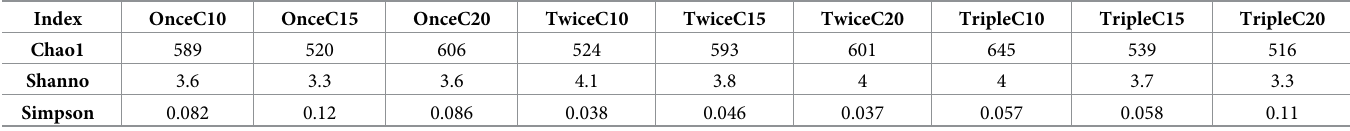
Table 4. Bacterial diversity in shrimp Litopeaneus vanname gut.